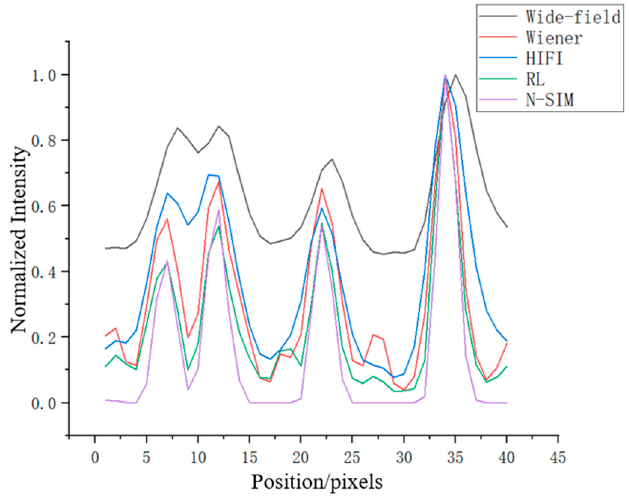
Figure 7. Fluorescence intensity statistics at the red line position in Figure 5. In order to verify that N-SIM algorithm has more obvious suppression effect on back- ground noise, the fluorescence intensity fluctuation on the yellow line (the yellow line only contains the fluorescence information of the background area) of the background area in Figure 6a was analyzed. The results are shown in Figure 8 below. It can be found that the fluorescence intensity fluctuation of the image reconstructed with N-SIM algo- rithm at its background position was smaller, and the overall range was close to zero. Therefore, N-SIM algorithm had a better suppression effect on the defocused background than the other three reconstruction algorithms. Figure 8. ( a ) Wiener-SIM, HIFI-SIM, RL-SIM and N-SIM are respectively used to reconstruct the sample image, and the fluctuation of fluorescence intensity on the yellow line in the background area is analyzed. ( b ) The distribution of fluorescence intensity of each pixel in the yellow line. 3.3. Validation of N-SIM Since the principle of this method was realized by suppressing the low-frequency spectrum of the sample, it might have affected the effective information (sample structure information) of the sample. In order to verify the effectiveness of this method, an adjusta- ble parameter was given in this paper to control the suppression of the notch function on the low-frequency of the center position. When setting different values, different results would be obtained. It can be seen from Figure 9 that the red arrow points to a mitochon- drion with weak signal strength. When σ = 2, the whole image could not only suppress the background noise, but also maintain the effective information of the samples.